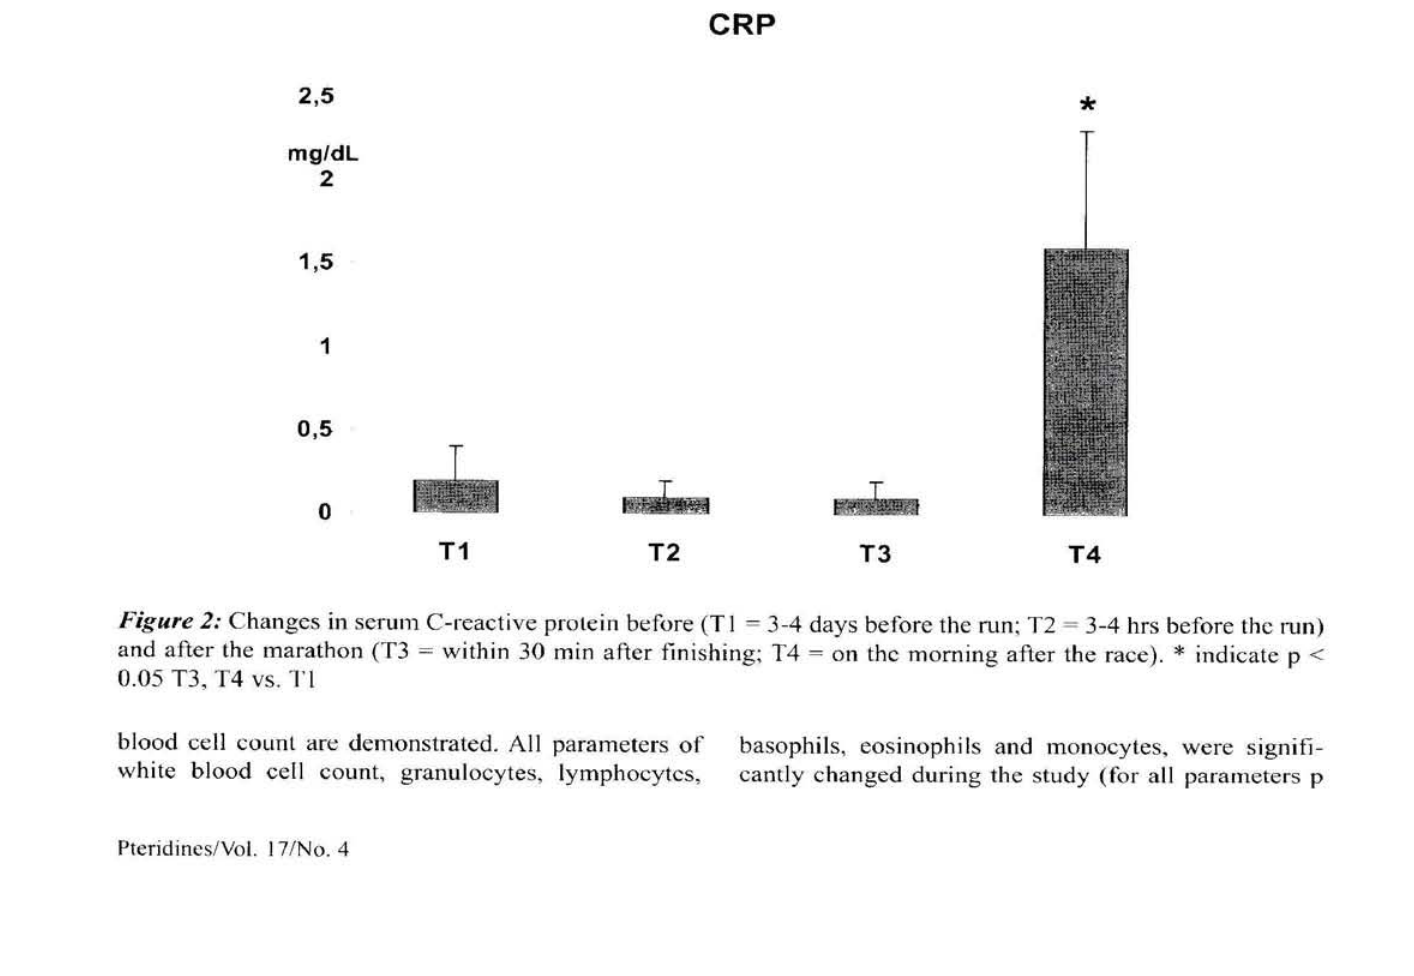
Figure 2: Changes in serum C-reactive protein before (Τ 1 - 3-4 days before the run; T2 = 3-4 hrs before the run) and after the marathon (T3 = within 30 min after finishing; T4 = on the morning after the race). * indicate ρ < 0.05 T3, T4 vs. TI blood cell count are demonstrated. All parameters of basophils, eosinophils and monocytes, were signifi- white blood cell count, granulocytes, lymphocytes, cantly changed during the study (for all parameters ρ